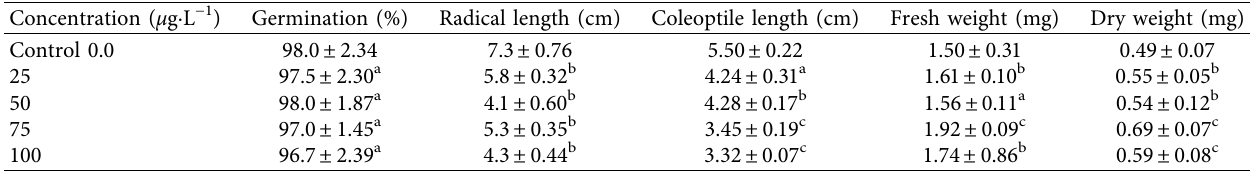
Table 3: Te efect of the phytotoxicity of diferent concentrations (25, 50, 75, and 100 μ g · L − 1 ) of AgNPs on wheat germination and seedling growth.